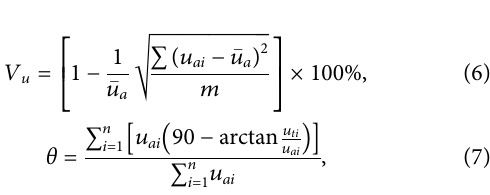
FIGURE 10 | Energy characteristics in the inlet passage for each case. (A) Q/Q d = 0.8 (B) Q/Q d = 1.0 (C) Q/Q d = 1.2.